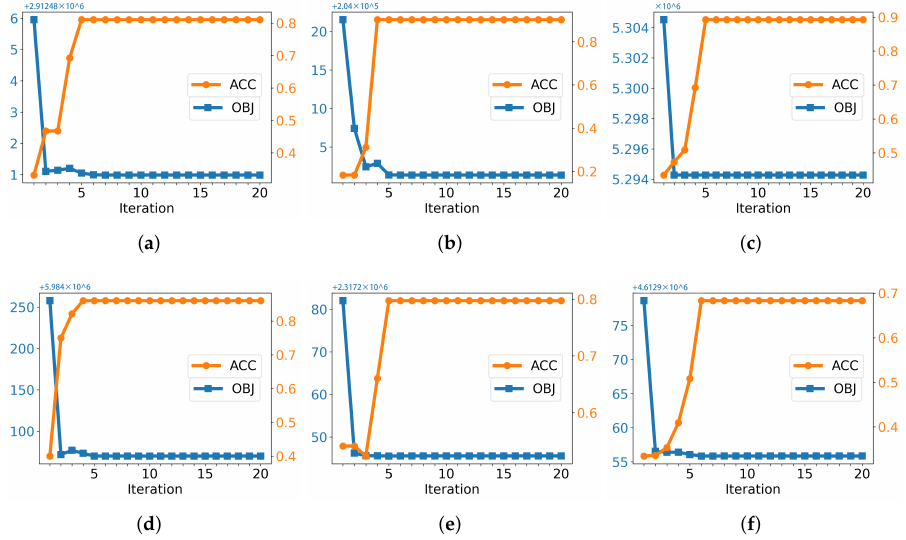
Figure 6. Convergence analysis of the proposed method, where OBJ denotes the objective